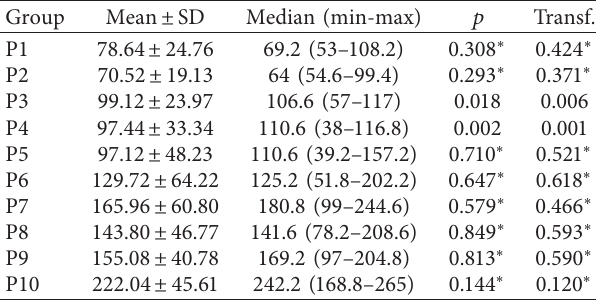
Table 2: Descriptive statistics and normality testing of fibroblast data using the Shapiro–Wilk